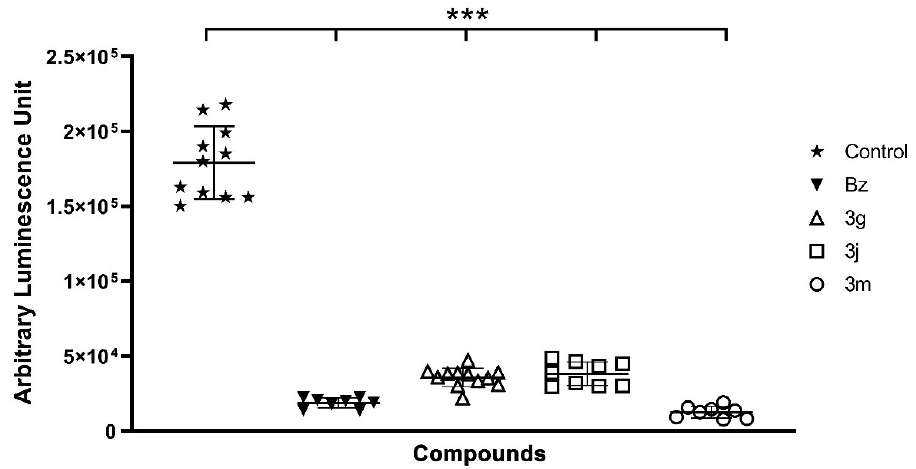
Figure 5. Biological activity of 3g , 3j and 3m in T. cruzi -infected microtissue. Determination of intracellular parasite viability by luciferase enzyme activity (Arbitrary luminescence unit; ALU). Treatment with pyrazole derivatives, with emphasis on 3m , and Bz induced a reduction of parasite load in the microtissue. (***) Statistically significant in relation to the untreated group using the One ‐ Way ANOVA test, with p < 0.001 (***).